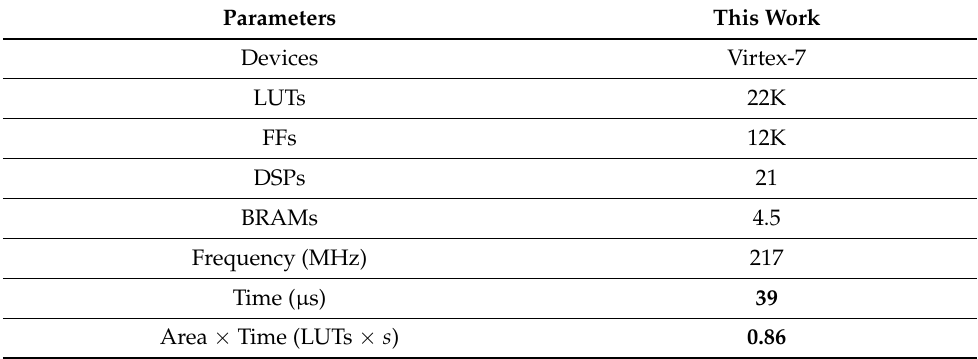
Table 2. Implementation results of Kyber key generation